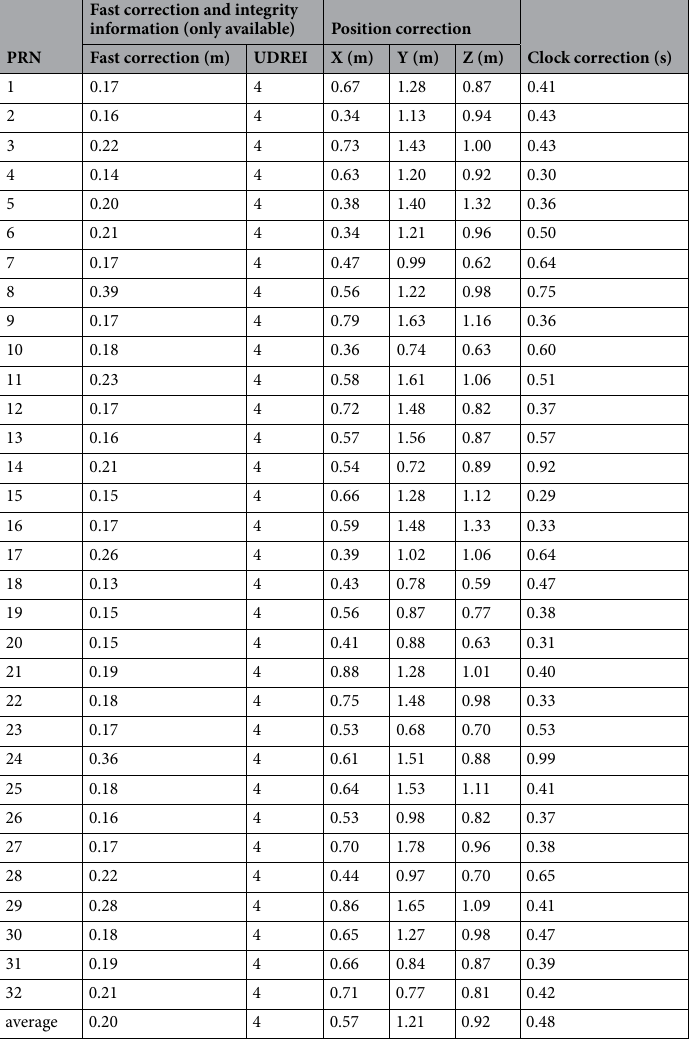
Table 2. Fast correction, positioning and clock correction information of GPS satellites broadcasted from Dec 11 to 31,